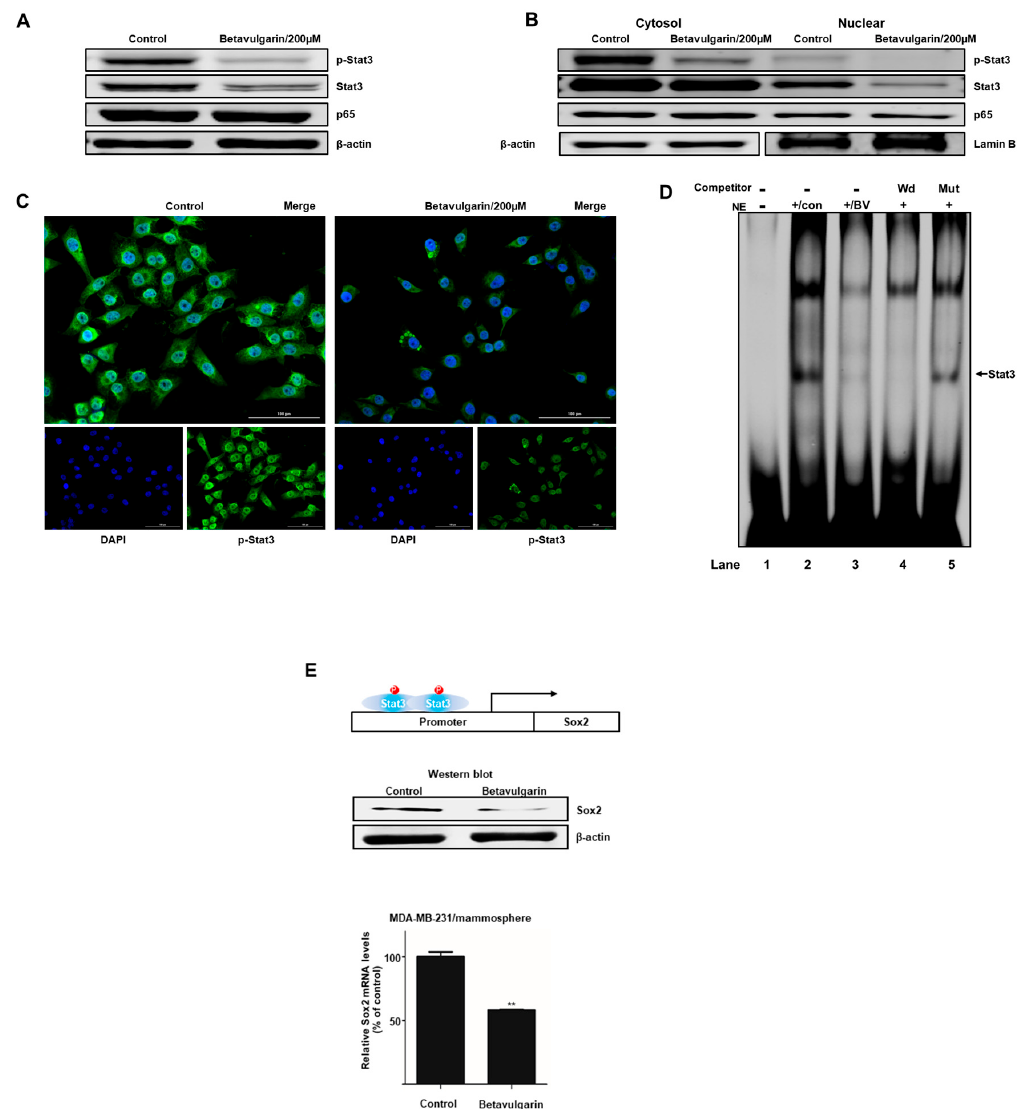
Figure 5. The e ff ect of betavulgarin on the Stat3 signaling pathway. ( A ) The levels of p-Stat3, Stat3, and p65 in isolated total protein from MDA-MB-231-derived mammospheres were measured after treatment with betavulgarin for 48 h, using Western blot analysis. ( B ) The nuclear protein levels of Stat3 and NF- κ B were determined in MDA-MB-231-derived mammospheres treated with betavulgarin (200 µ M) or DMSO. Betavulgarin blocked the translocation of Stat3 and decreased the level of p-Stat3 in mammospheres. ( C ) Immunofluorescence (IF) analysis of p-Stat3 (green) expression and localization in breast cancer cells treated with betavulgarin or DMSO was performed (scale bar: 100 µ m). ( D ) Electrophoresis mobility shift assays (EMSAs) of MDA-MB-231-derived mammosphere nuclear proteins after treatment with betavulgarin were performed. Nuclear extracts were incubated with a Stat3 probe and separated by 5% native PAGE. Lane 1-Stat3 probe only; Lane 2-untreated nuclear extracts with the Stat3 probe; Lane 3-betavulgarin-treated nuclear proteins with the Stat3 probe; Lane 4-untreated nuclear proteins incubated with a self-competitor (100 × ) oligo; and Lane 5-untreated nuclear extracts incubated with a mutated-Stat3 (100 × ) probe. The arrow indicates the DNA / stat3 complex in the mammosphere nuclear lysates. ( E ) Treatment of tumorspheres with betavulgarin (200 µ M) for 48 h decreased the mRNA and protein levels of SOX2. The transcription of the SOX2 gene was assayed with specific real-time RT-qPCR primers. The SOX2 protein was identified with an anti-SOX2 antibody. β -actin was used as an internal control. The data are presented as the mean ± SD of three independent experiments. ** p < 0.05 versus the DMSO-treated control